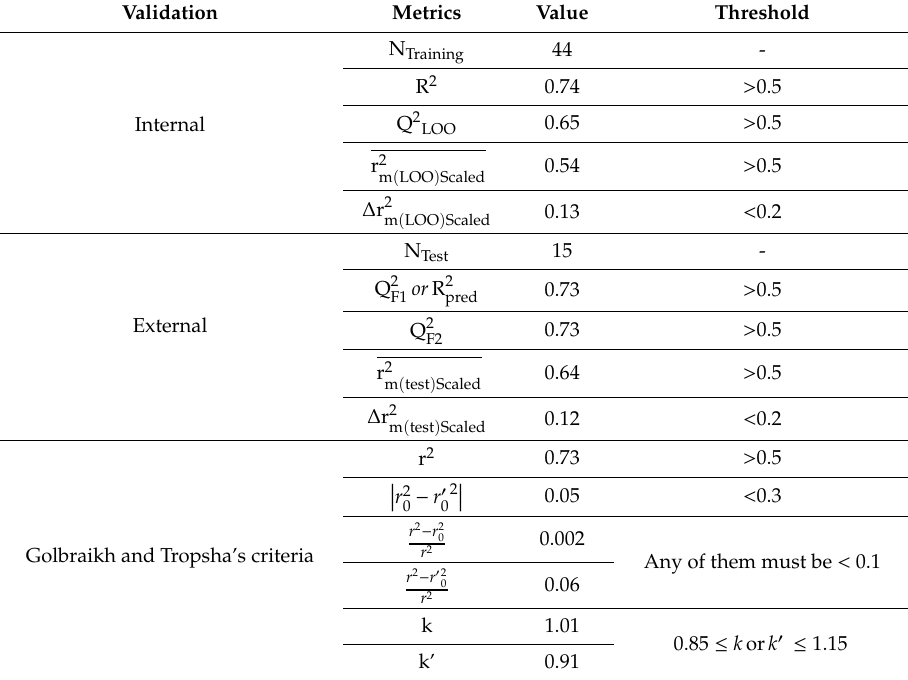
Table 2. Obtained statistical data from the developed quantitative structure-property relationship (QSPR)